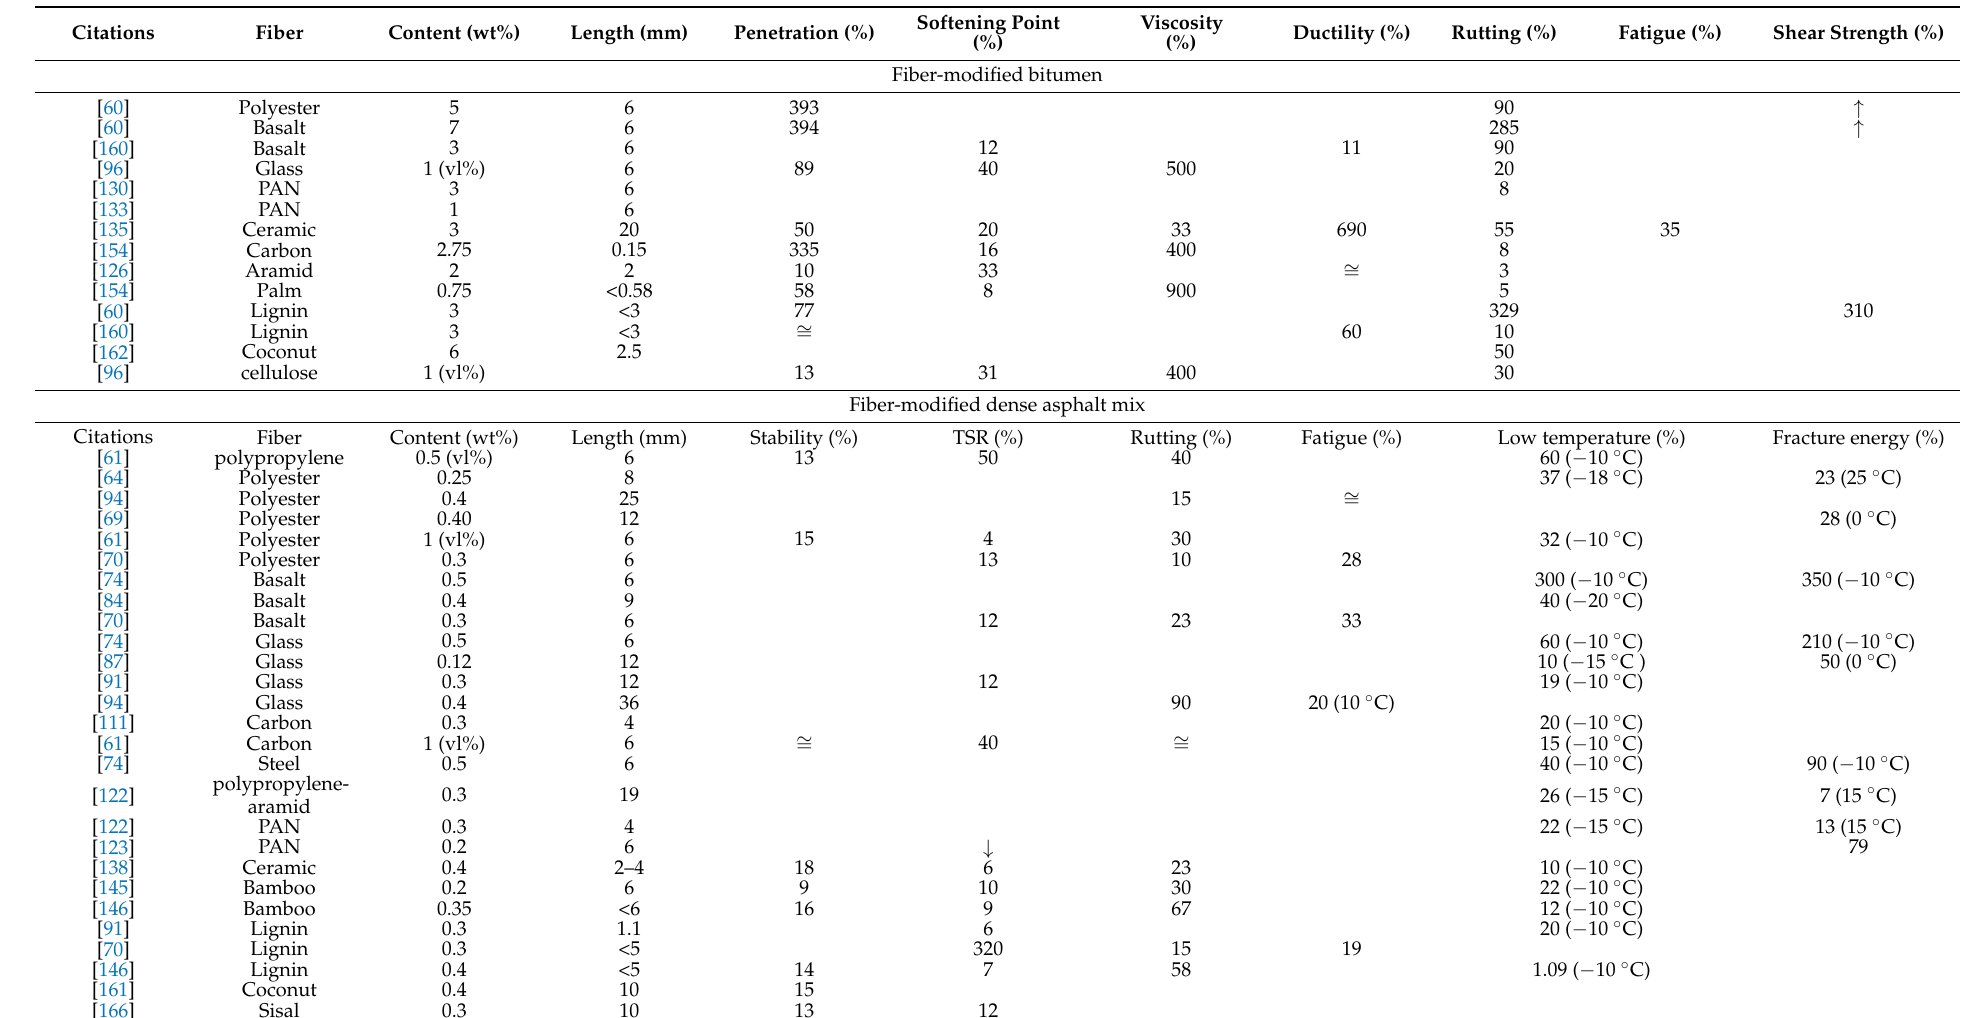
Table 3. Summary of